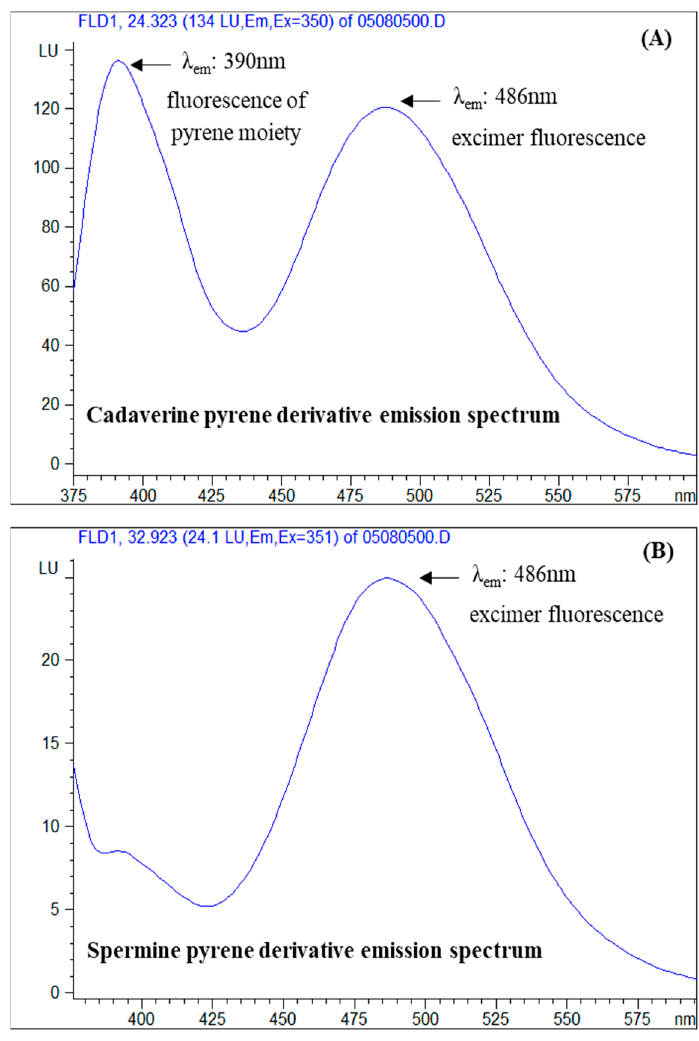
Figure 6. Emission spectra of ( A ) cadaverine and ( B ) spermine pyrene derivative chromatographic peaks. Retention times approximately 24 and 33 min, respectively.